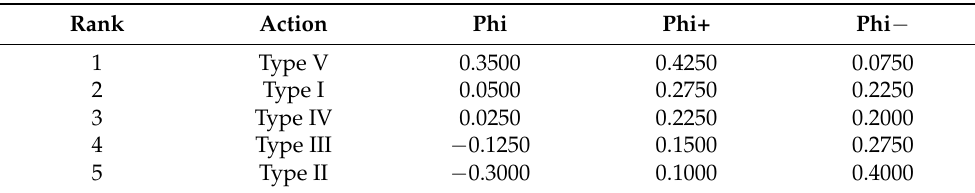
Table 2. Phi, Phi+, and Phi − values for community-based village development strategies in Cigalontang District, Tasikmalaya